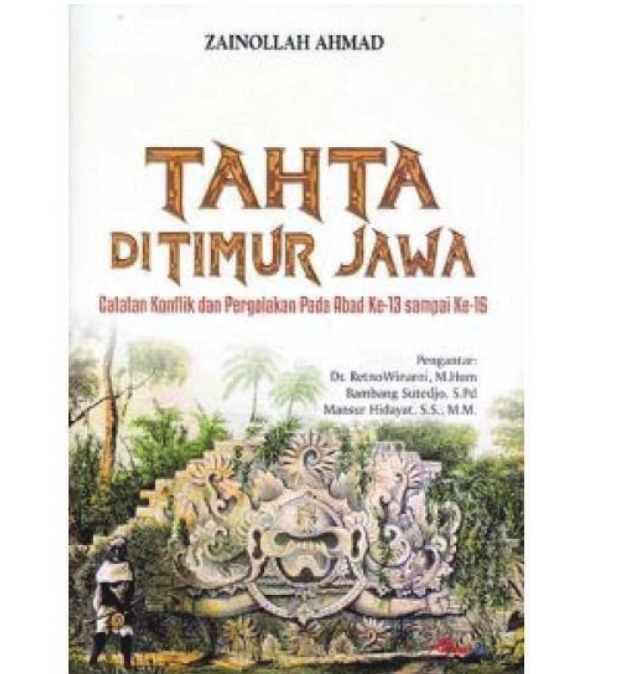
Fig 1. The book cover of Zainollah Ahmad’s "Tahta di Timur Jawa” Tabel 1. The baseline charactristics of participants